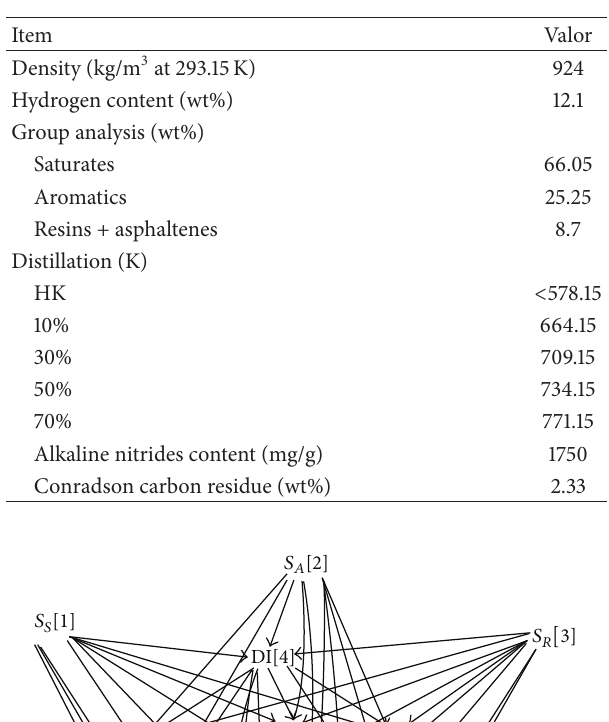
Table 3: Lumps of the 12-lump kinetic model